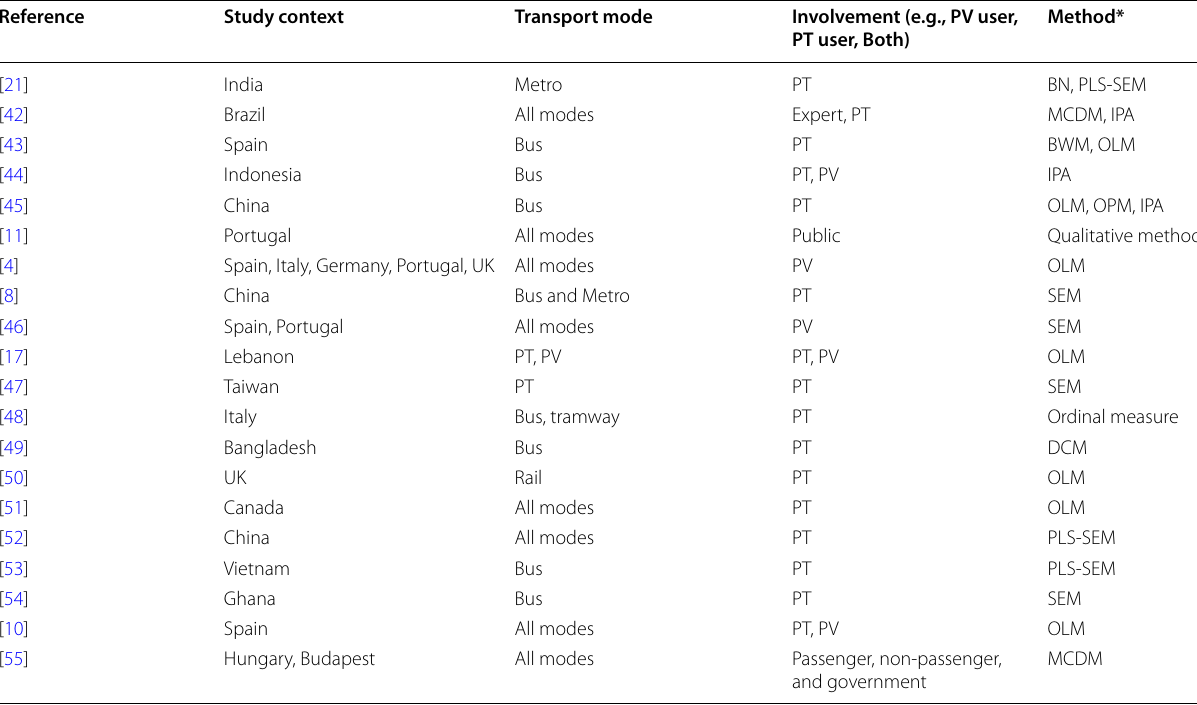
Table 1 Studies measuring the quality of PT services and travelers’